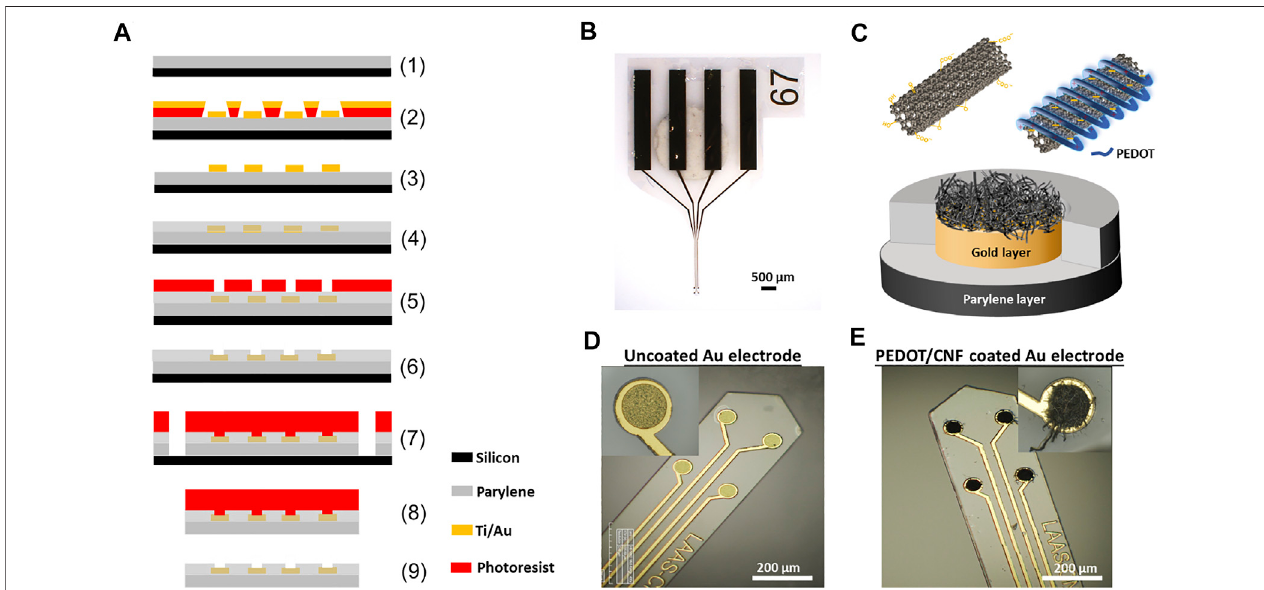
FIGURE1| Schematicillustrationandopticalimagesofneuralimplant. (A) Schematicoverviewofstepsinvolvedinthemicrofabricationprocedure-(1)23 µmthick Parylene C deposition on SiP wafer; (2) Photo-patterning of nLof and gold layer deposition (Ti/Au-50/200 nm); (3) nLof removal; (4) 2nd Parylene C layer (1.3 µm) deposition and anneal at 110 ° C for 16 h; (5) Spin coating of 5 µm thick AZ4562 photoresist; (6) RIE with ICP-RIE oxygen plasma; (7) Photo-patterning with BPN photoresist and RIEwith ICP-DRIE oxygen plasma; (8) Stripping of implants from SiP wafer and (9) Developmentwith NF52 and cleaning with DI water. (B) Optical micrograph of the neural implant. (C) Schematic representation of the PEDOT-CNF composite deposition. (D) and (E) Optical micrographs showing the neural microelectrodes before and after surface modi fi cation with PEDOT-CNF composite.